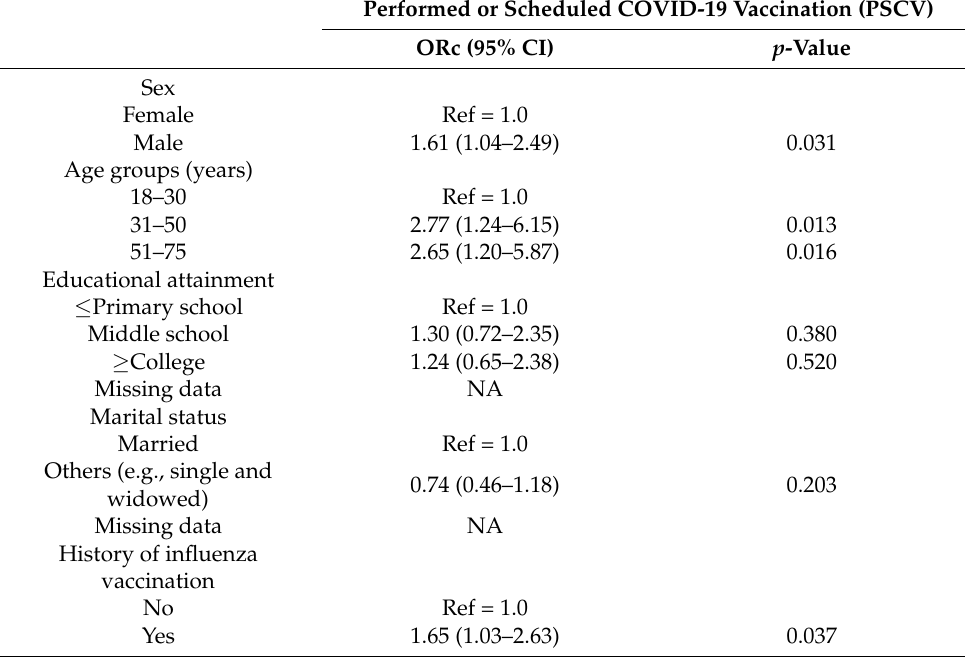
Table 3. Background factors of performed or scheduled COVID-19 vaccination (n = 500). Performed or Scheduled COVID-19 Vaccination (PSCV) ORc (95% CI) p